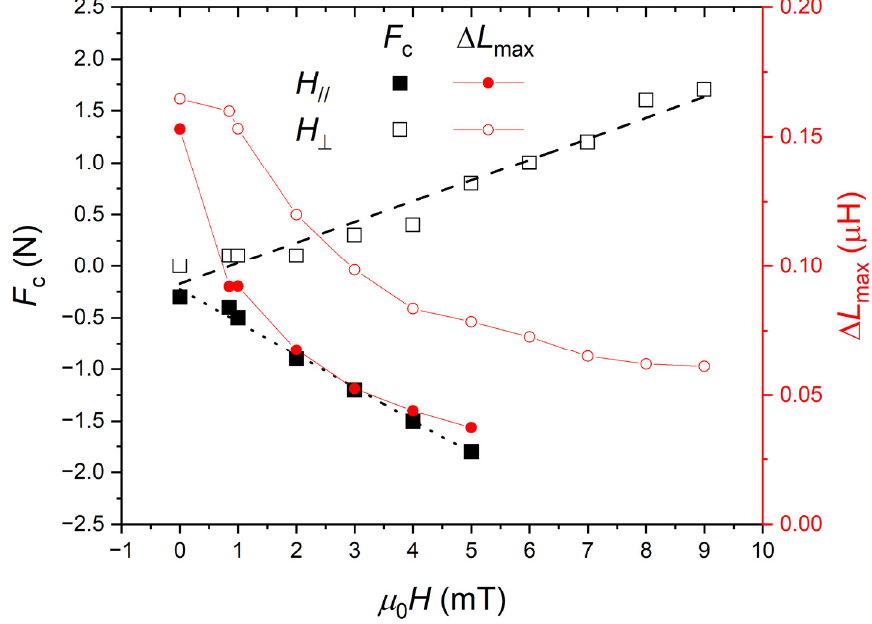
Figure 4. Experimental peak parameters: critical force F c and maximal coil inductance change Δ L max versus the applied force. Data for the longitudinal ( H // ) and orthogonal ( H Ʇ ) configuration.